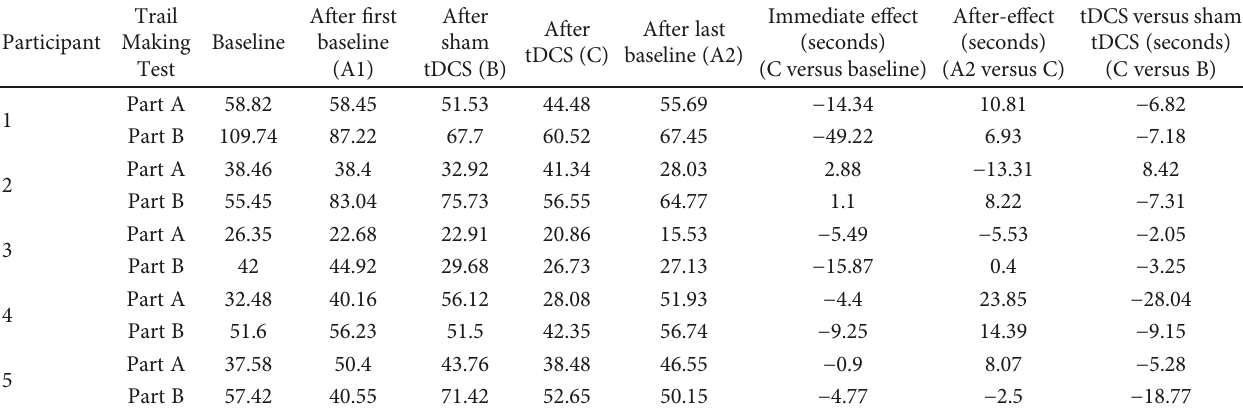
Table 2: Trail Making Test